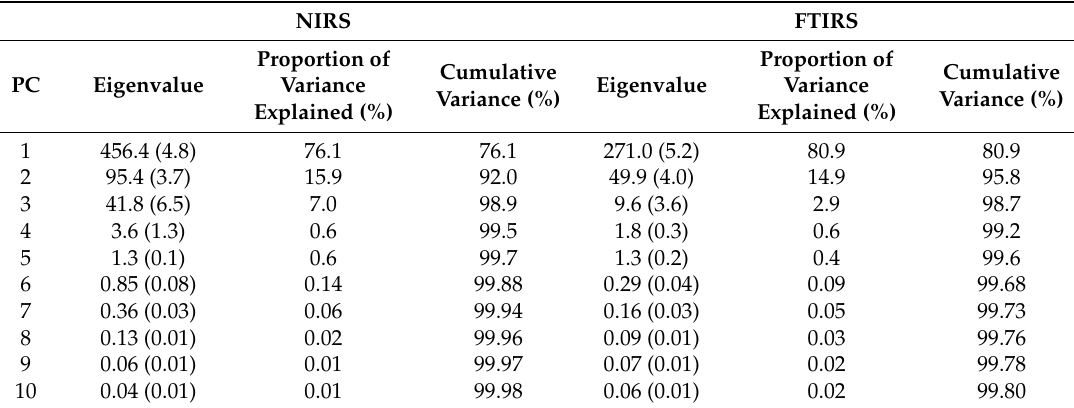
Table 1. Eigenvalues of the correlation matrix 1 .